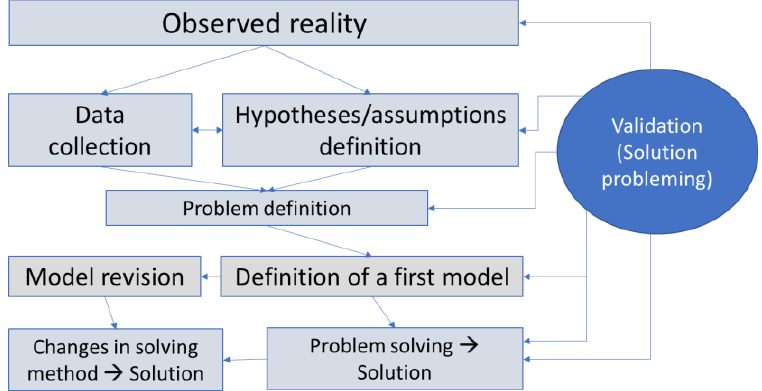
Figure 1. The problem solving cycle of Ackoff extended and adapted (authors’elaboration from Gonzalez-Feliu’s [70], considerations).